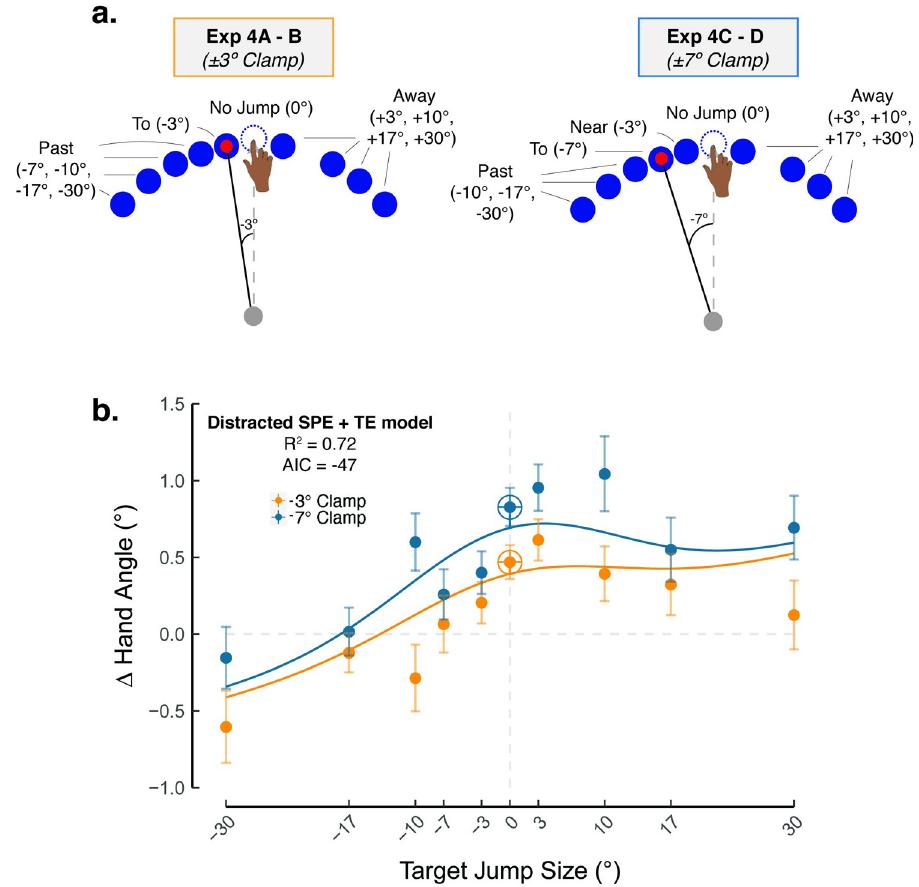
Fig 6. Implicit recalibration reflects the contribution of learning from task error and sensory prediction error, with the latter sensitive to distraction from target jumps (Exp 4). . (a)–(b) Participants experienced a randomized zero-mean perturbation schedule with clamp sizes (-3˚ shown in orange; -7˚ shown in blue) × target jumps (x axis, -30˚ through 30˚). The Distracted SPE + TE model was the winning model.